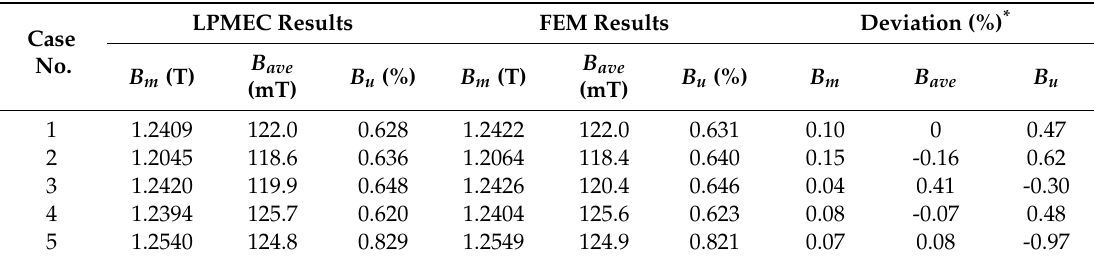
Table 3. Comparison of improved LPMEC model and